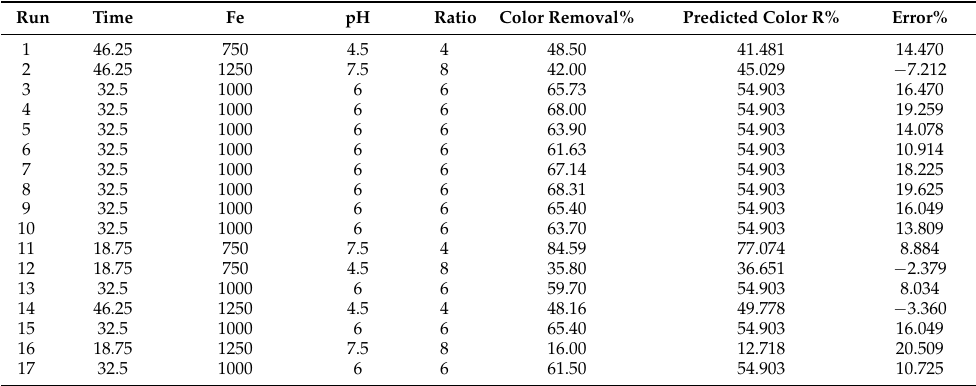
Table 6. Experimental design and results for color